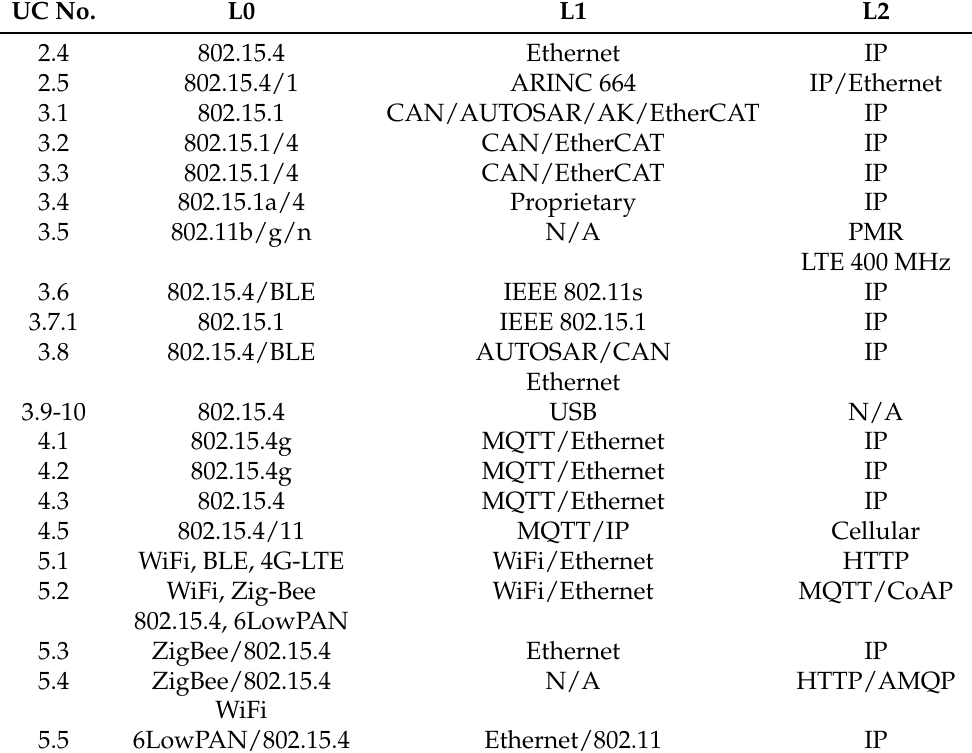
Table 12. DEWI use cases in the